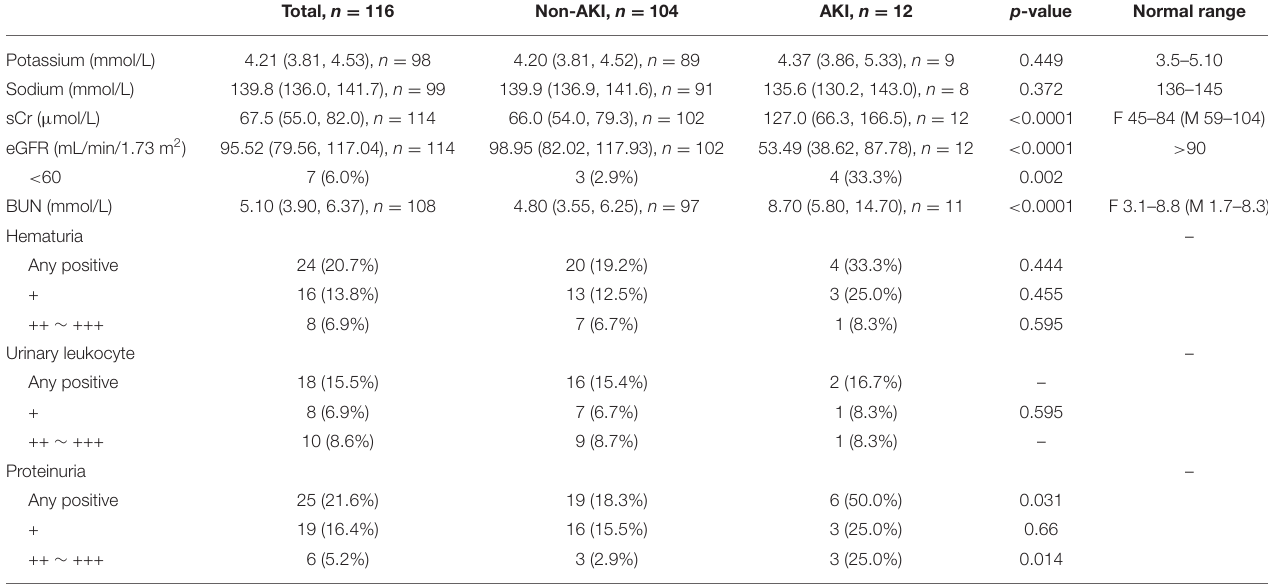
TABLE 3 | Laboratory findings of the kidney function of the patients on